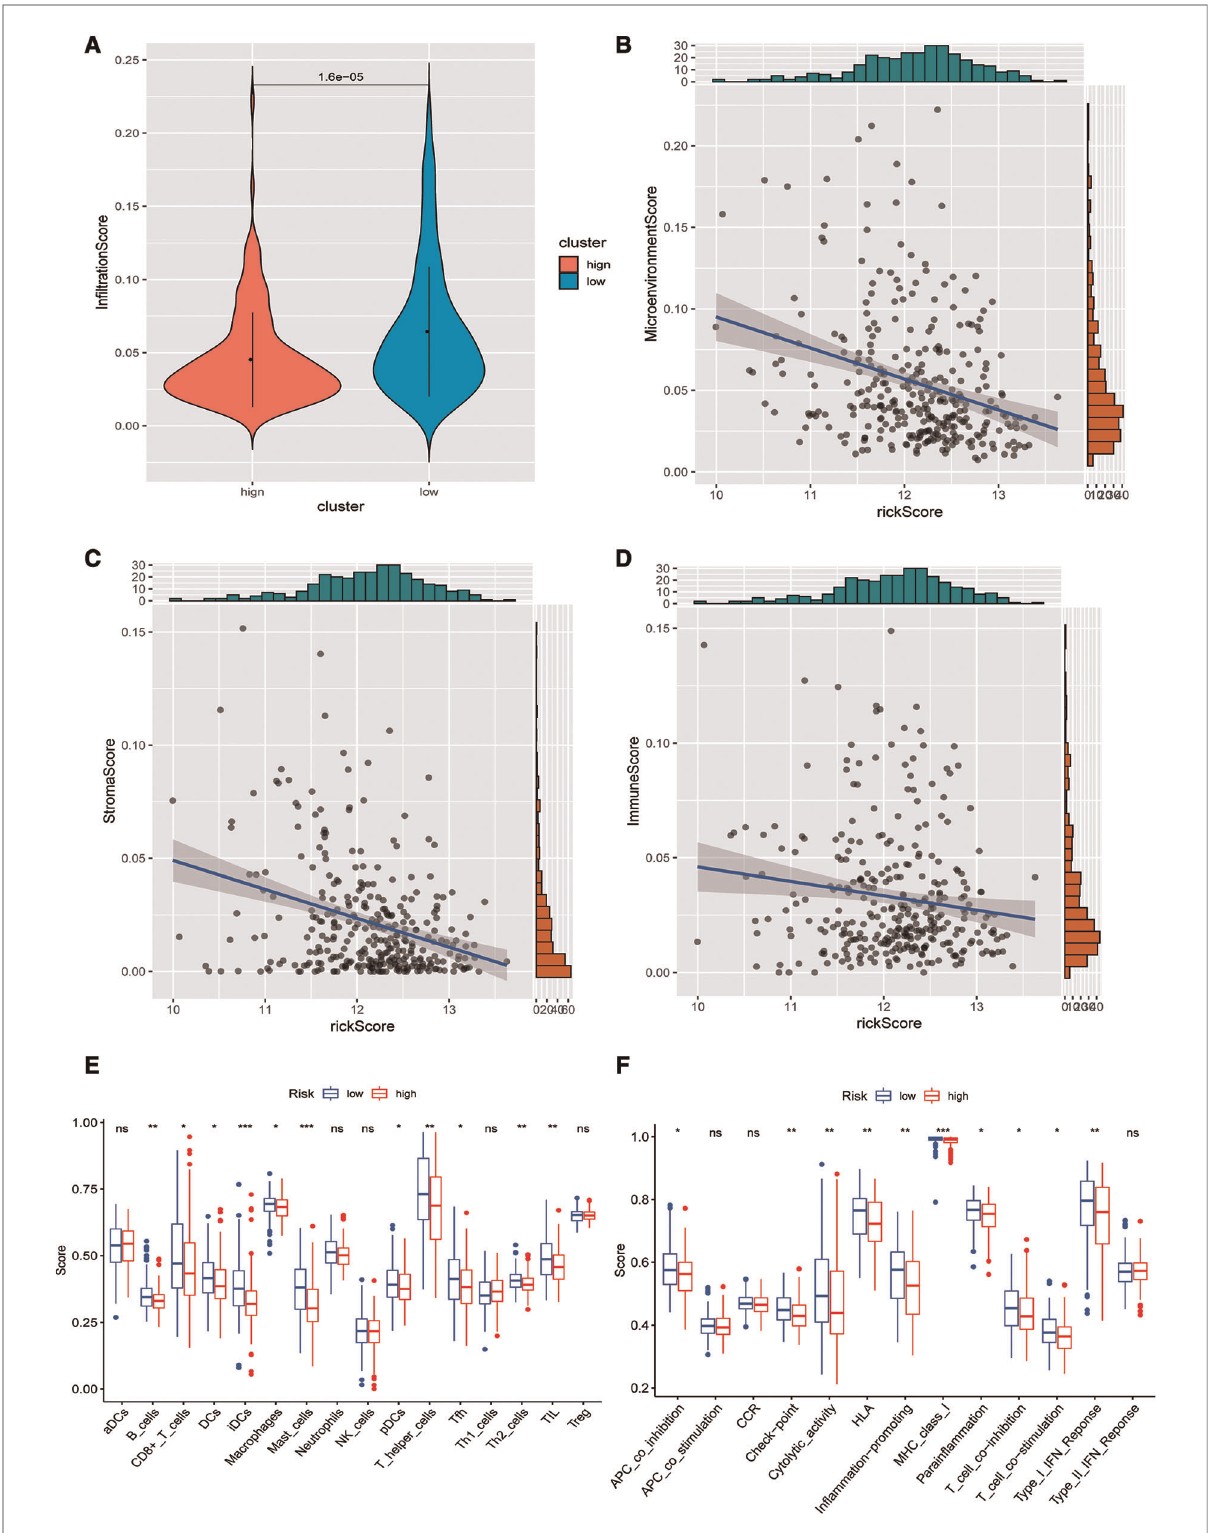
FIGURE 3 Identi fi cation of pyroptosis-related key regulators. ( A ) Correlation network diagram of 278 pyroptosis-related key regulators and 42 pyroptosis- related genes. Expression heat map ( B , C ) and methylation heat map ( D ) of 278 pyroptosis-related key regulators in the training dataset. ( E ) PCA clustering of 278 pyroptosis-related key regulators in the training dataset. ( F ) Prognostic forest map of 13 pyroptosis-related